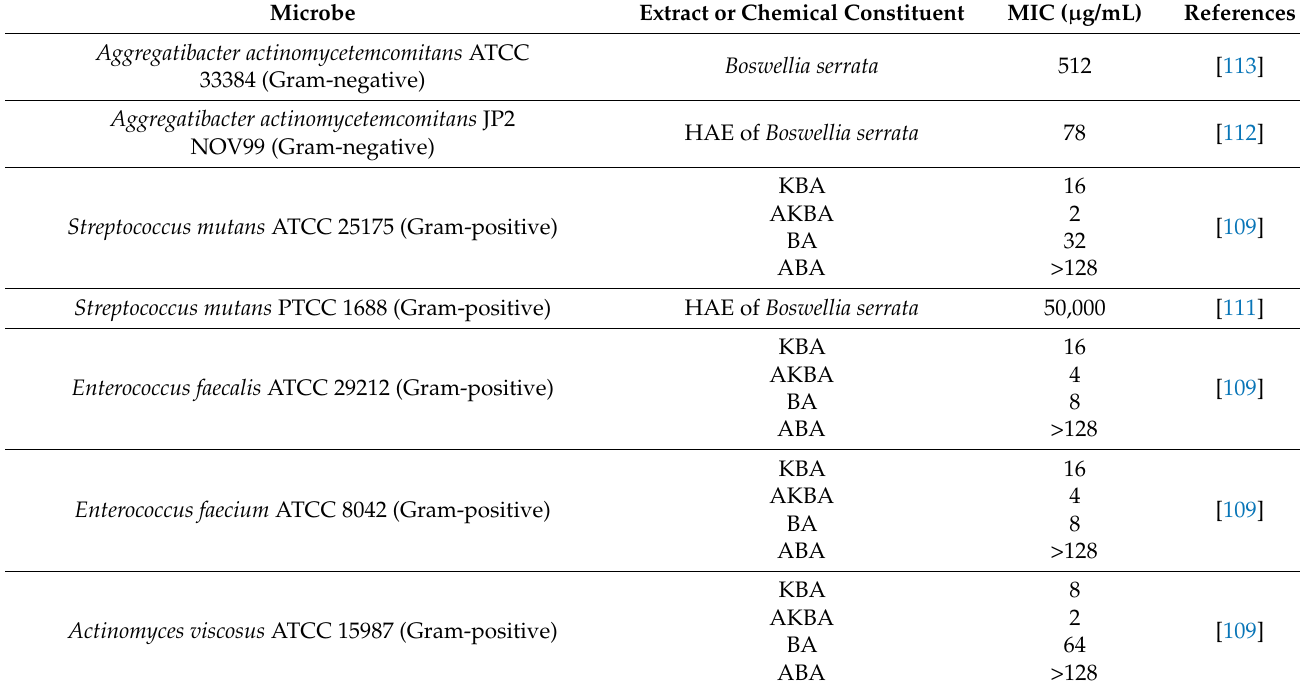
Table 3. Boswellic acid extracts or chemical constituents with antimicrobial activity against oral pathogens in